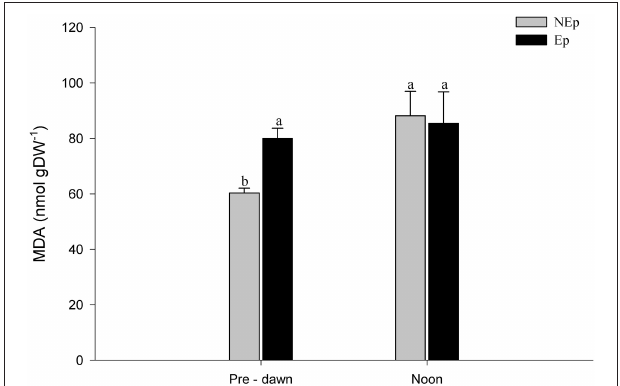
FIGURE 7 | Malondialdehyde (MDA) concentration in Posidonia oceanica leaves with (Ep) and without (NEp) epiphytes, at pre-dawn and noon. Different letters indicate significant differences between pre-dawn and noon. TABLE 1 | Responses of Posidonia oceanica to the presence of epiphytes and to the pre-dawn to noon shift. Effect of